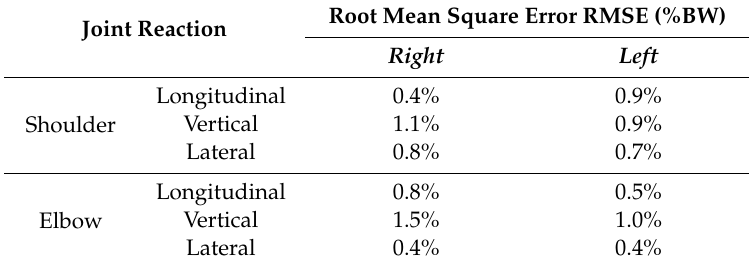
Table 3. Comparison between inverse dynamic results. All tests were used. Results are expressed as a percentage of the total weight of subjects and